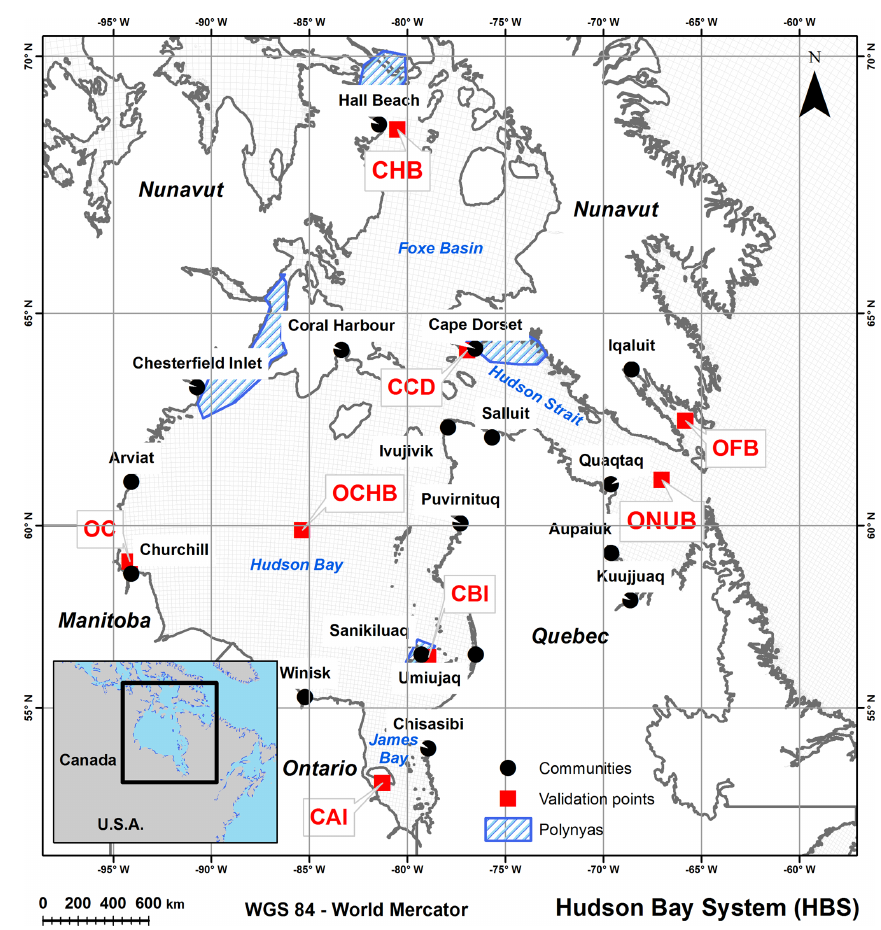
Figure 1. The Hudson Bay system with communities, model validation points and